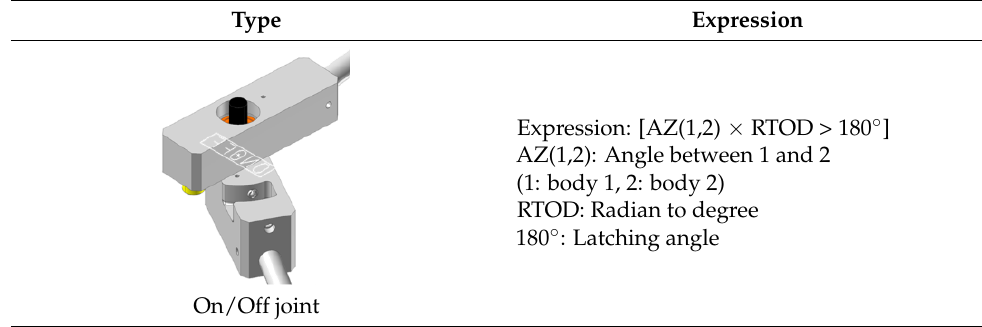
Table 6. Expression function for latching mechanism.